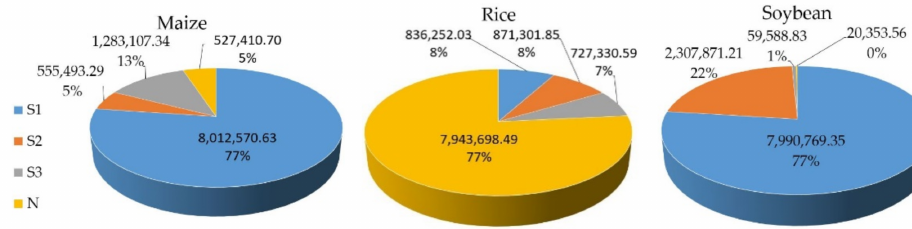
Figure 7. The areas of the three crops in different grades after optimization (ha). S1: highly suitable, S2: moderately suitable, S3: marginally suitable, N: